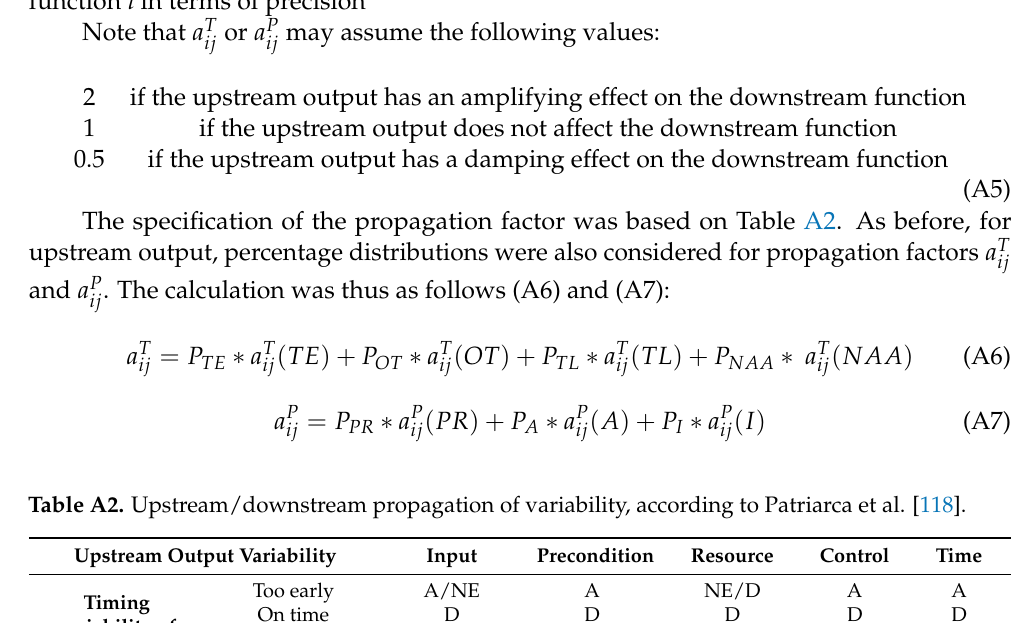
Table A2. Upstream/downstream propagation of variability, according to Patriarca et al. [118]. Upstream Output Variability Input Precondition Resource Control Time Too early A/NE Timing variability of output Precision Imprecise A A variability of Acceptable NE NE output Precise D D A = Amplifying, NE = No Effect, D =